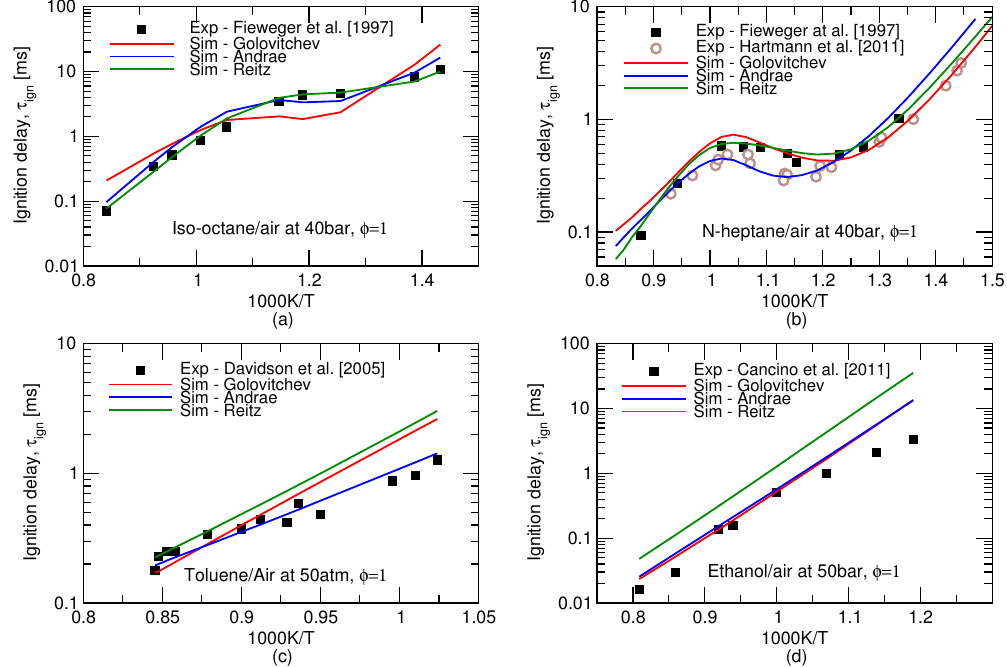
Figure 1. Ignition delay time predictions (lines) of four individual key gasoline surrogate components: ( a ) iso-octane, ( b ) n-heptane, ( c ) toluene ( d ) ethanol. Symbols show shock tube measurements of Fieweger et al. [17], Hartmann et al. [18], Davidson et al. [19] and Cancino et al. [15].